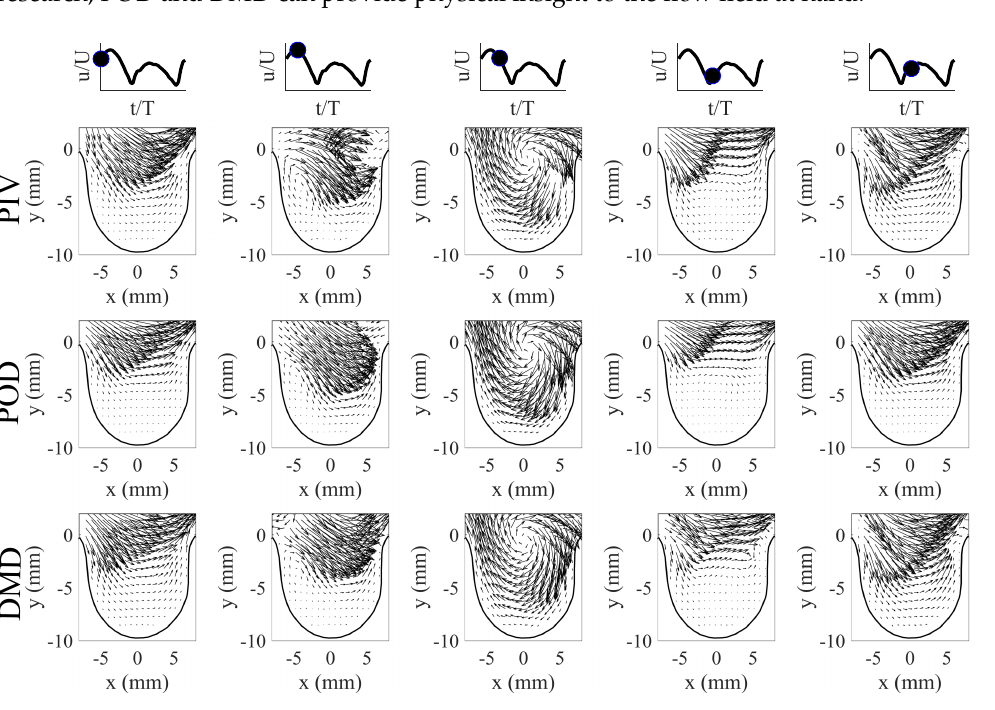
Figure 9. POD and DMD low-order reconstruction for the first half of the flow cycle for Re p = 50. First row: PIV results, Second row: POD results, Third row: DMD